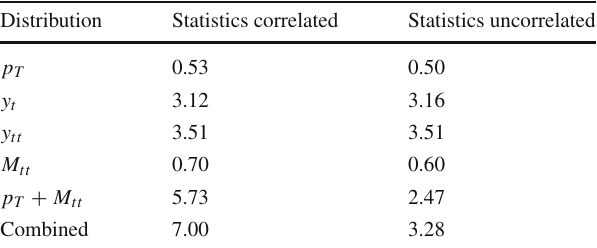
Table 1 χ 2 / N data values for fits to different distributions within the ATLAS 8 TeV lepton + jet data, as well as for the combined fit to all four distributions. The left (right) columns correspond to the case that the statistical correlations are included (excluded)